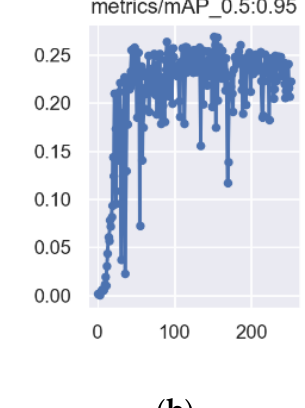
Figure A3. The change of mean average precision (mAP) of YOLOV5n: ( a ) mAP_0.5; ( b ) mAP_0.5:0.95.